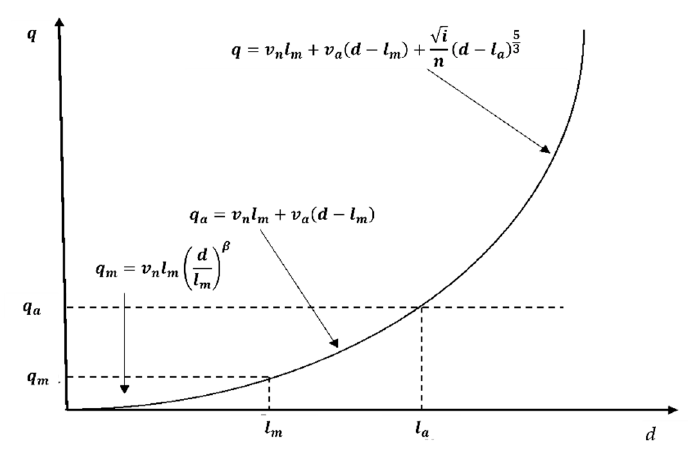
Figure 5. The relationship between the water depth and the unit width discharge ( q - d ) in each grid.